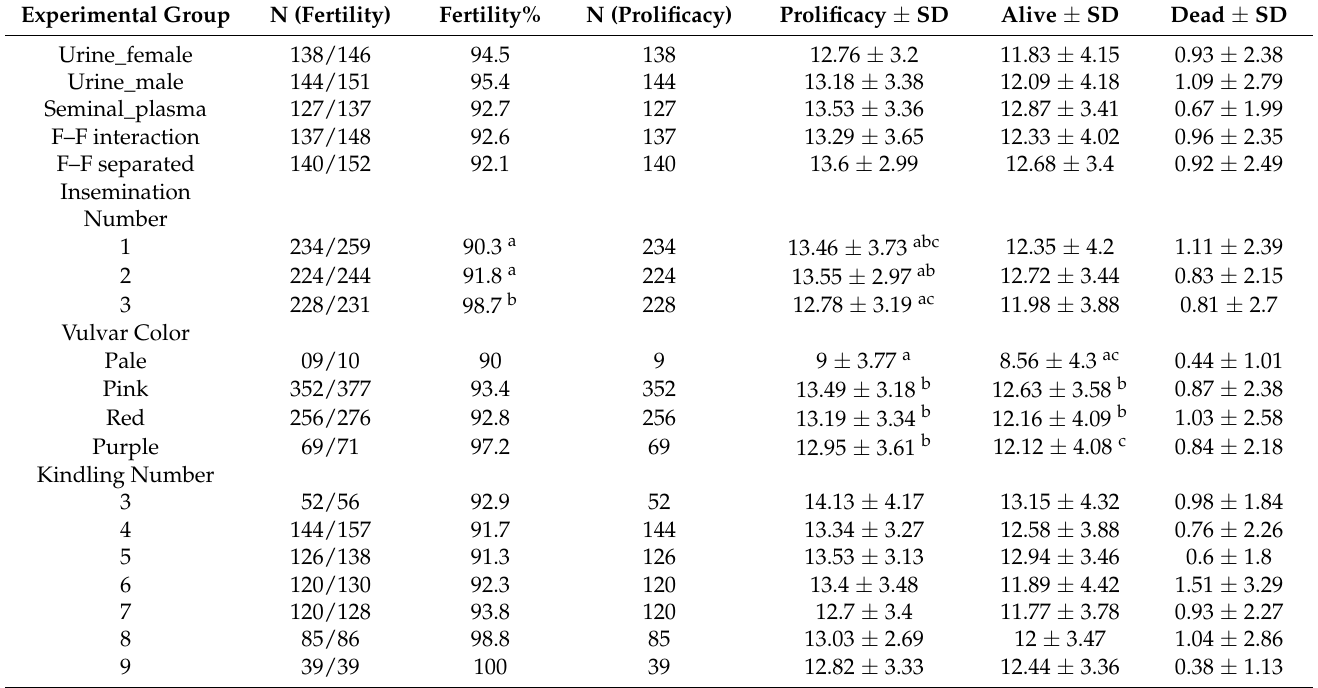
Table 2. Fertility (kindling rate), prolificacy (total born/litter) and number of born alive and dead kits/litter considering experimental group, insemination number, vulvar color and kindling number. N: number of positive/total female does. SD: standard deviation. Different letter in the same column indicates p -value <